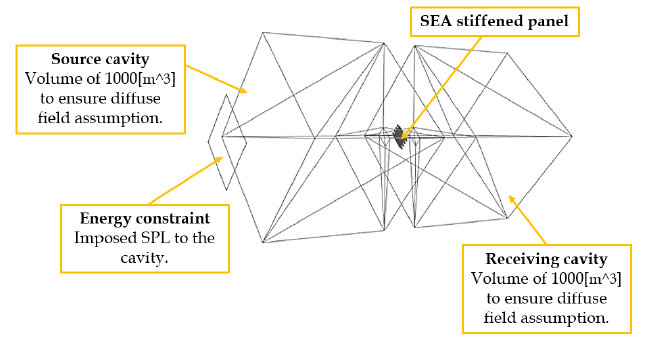
Figure 3. VAOne SEA Ribbed model (TL